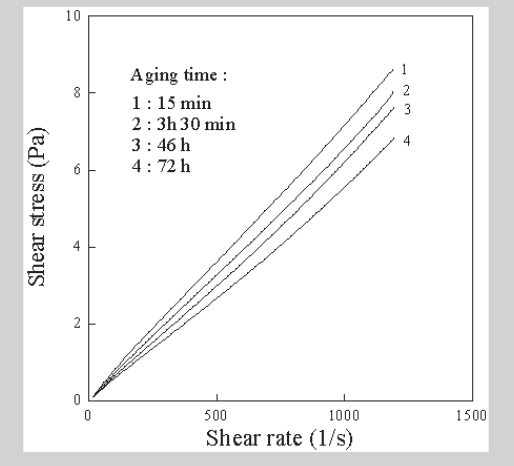
Figure 1 (left): Viscosity of oil-in-water emulsions versus volume oil concentration and comparison with the predicted curve of Krieger- Dougherty calculated with Eq. 4. Figure 2 (right): Flow curves of E1emulsion (26 vol. %) for different aging